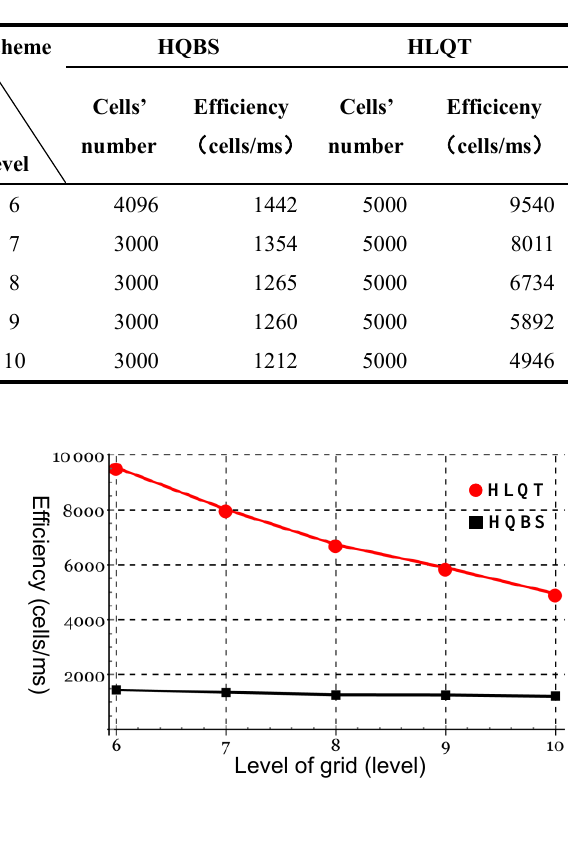
Table 2. Statistical Results of computaional efficency